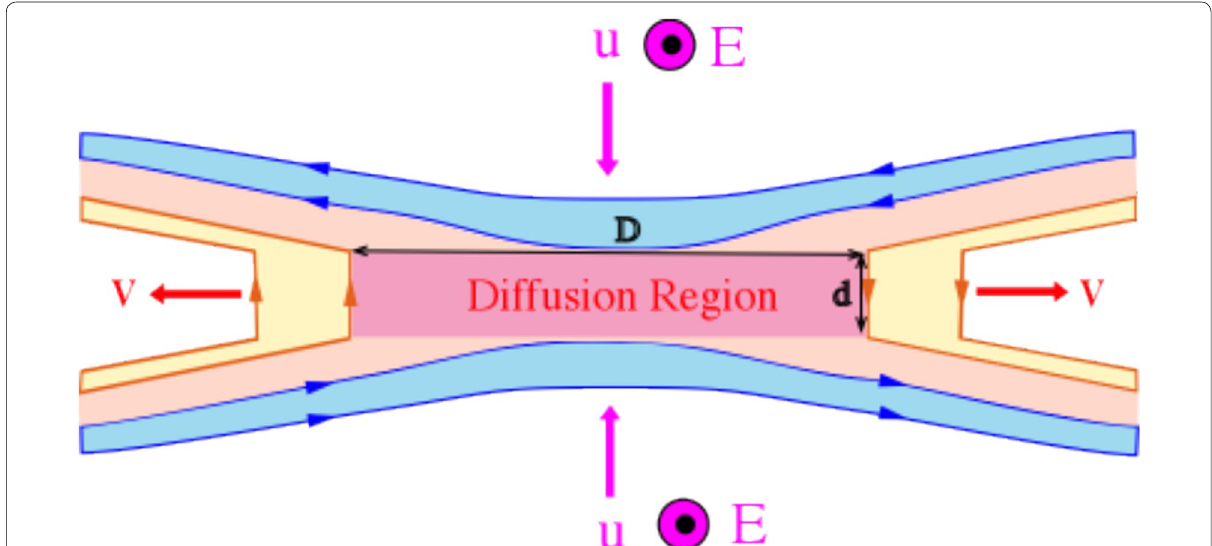
Fig. 1 Case of a magnetic reconnection site is used to examine whether or not one can visualize a magnetic field line moving across the diffusion region can transport the same amount of magnetic flux in its exit. The mismatch between incoming and outgoing magnetic flux indicates no cor- respondence between incoming magnetic field line and outgoing magnetic field